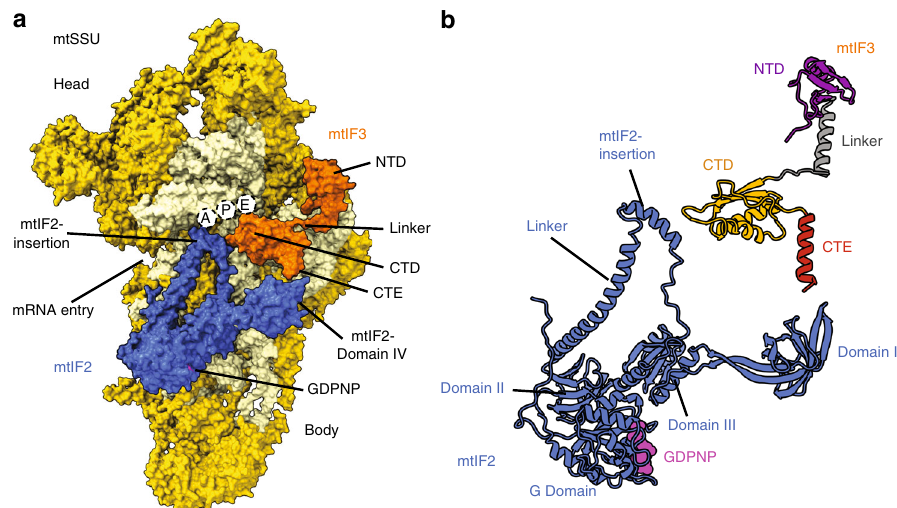
Fig. 1 Structure of the human mitochondrial preinitiation translation complex (mtPIC-2). a Surface representation of the mtSSU with mtIF3 (orange) and mtIF2 (blue). Empty tRNA-binding sites and mRNA channel are indicated. The binding of mtIF2 is accomplished due to mtIF3 NTD restricting the mtSSU head movement. b Relative positions of mtIF3 colored by domains (NTD purple, linker dark gray, CTD orange, CTE red) and mtIF2.